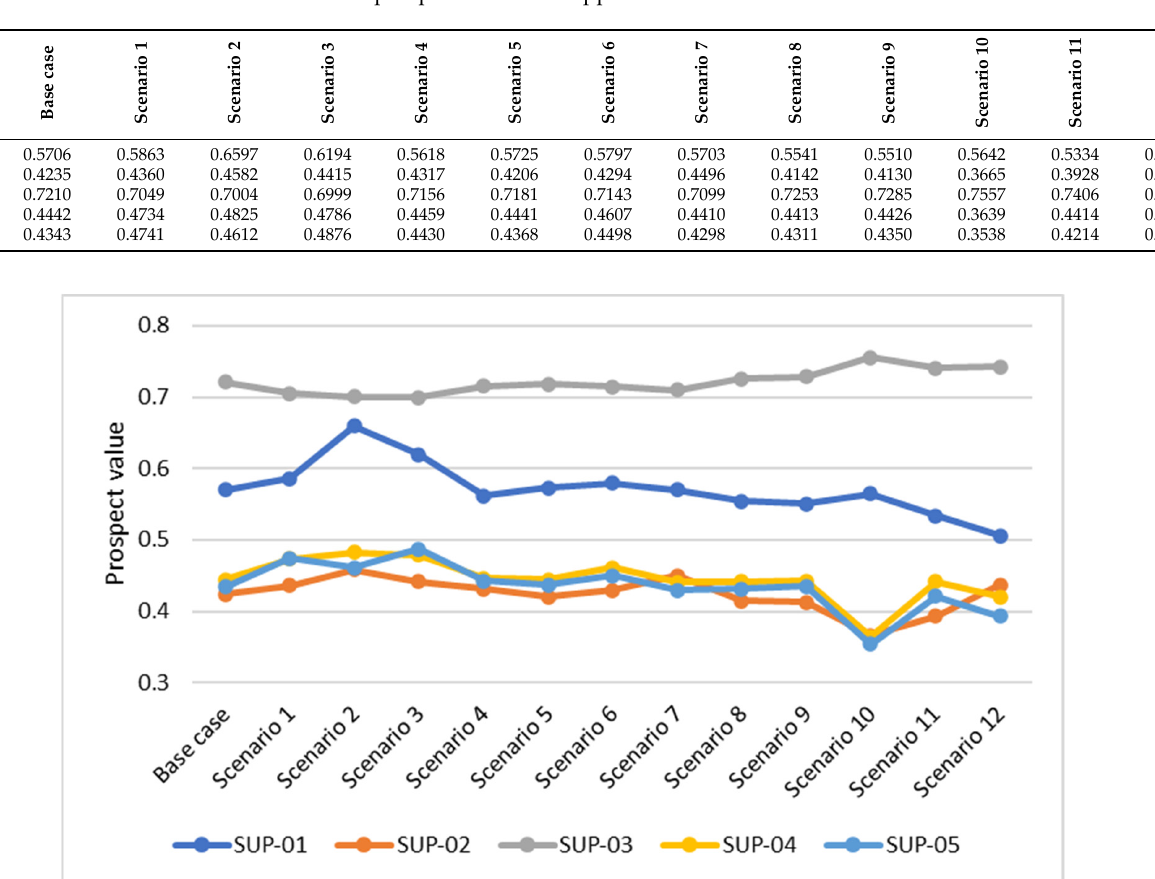
Figure 5. The ranking of suppliers for all scenarios.